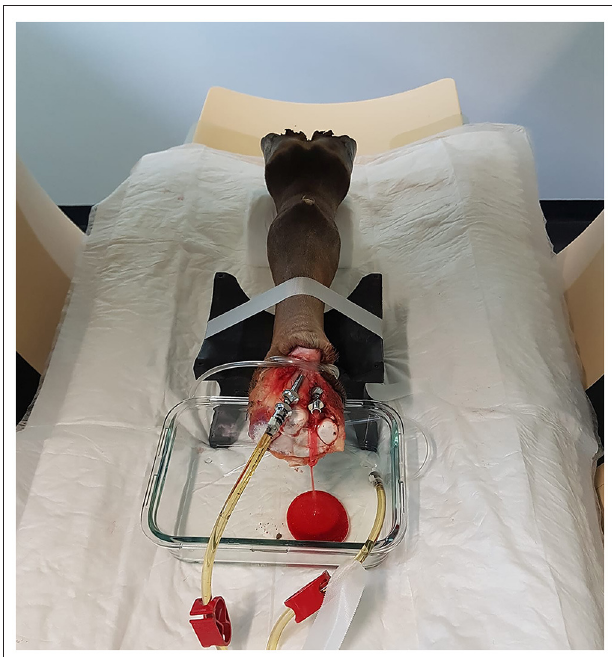
FIGURE 1 | Positioning of the limb within the CT-gantry using two stands and a glass container to collect exiting perfusate. For this scan, only the left tube of the perfusion system was connected to the radial vein, allowing drainage of blood and contrast agent through the catheter of the median